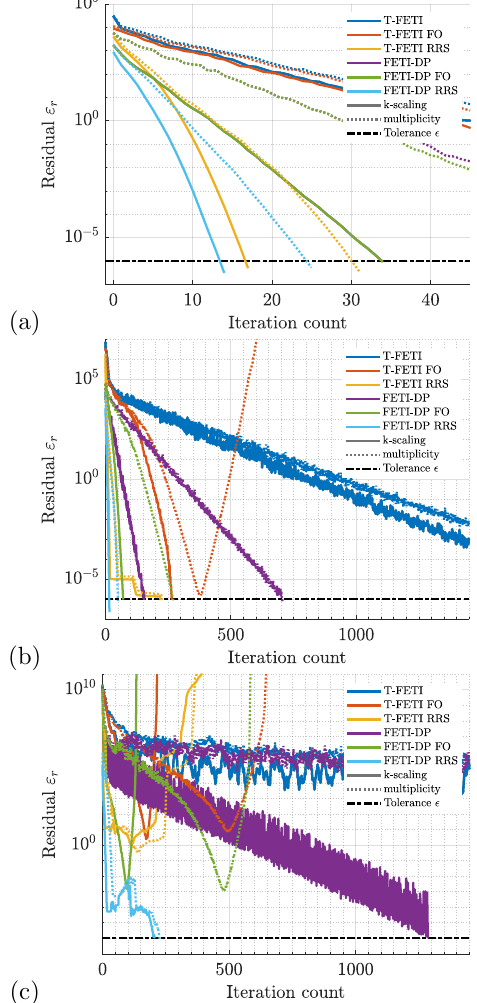
solution strategies for the three snapshots of modu- lar topology optimization from Fig. 4: a) 4 th , b) 8 th , and c) 30 th iteration of the topology optimization. Similarly to Fig. 2, FO denotes full orthogonalization enhancement, RRS stands for the simultaneous vari- ant with rank-revealing decomposition. In all graphs, results with the k -scaling enhancement are plotted in solid lines while the dotted lines represent the multi- plicity scaling. The dash-dotted line mark the desired residual threshold ϵ from Algorithm